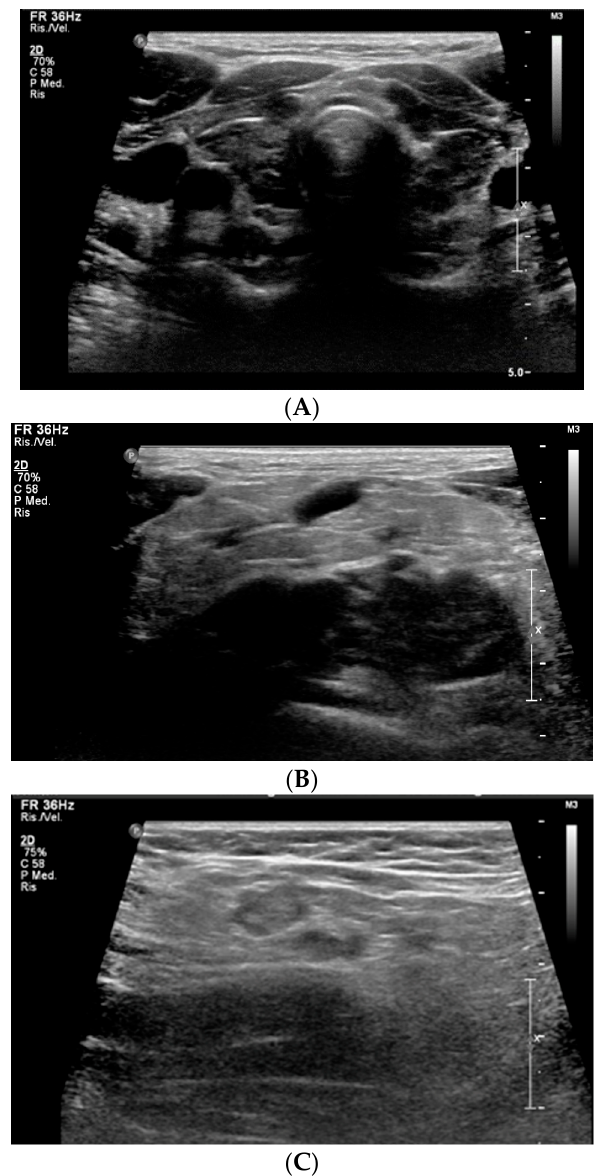
Figure 1. Ultrasound findings of thyroiditis ( A ), thickening and hyperechogenic of subcutaneous adipose tissue in the right supraclavicular region ( B ) and in the right armpit ( C ).